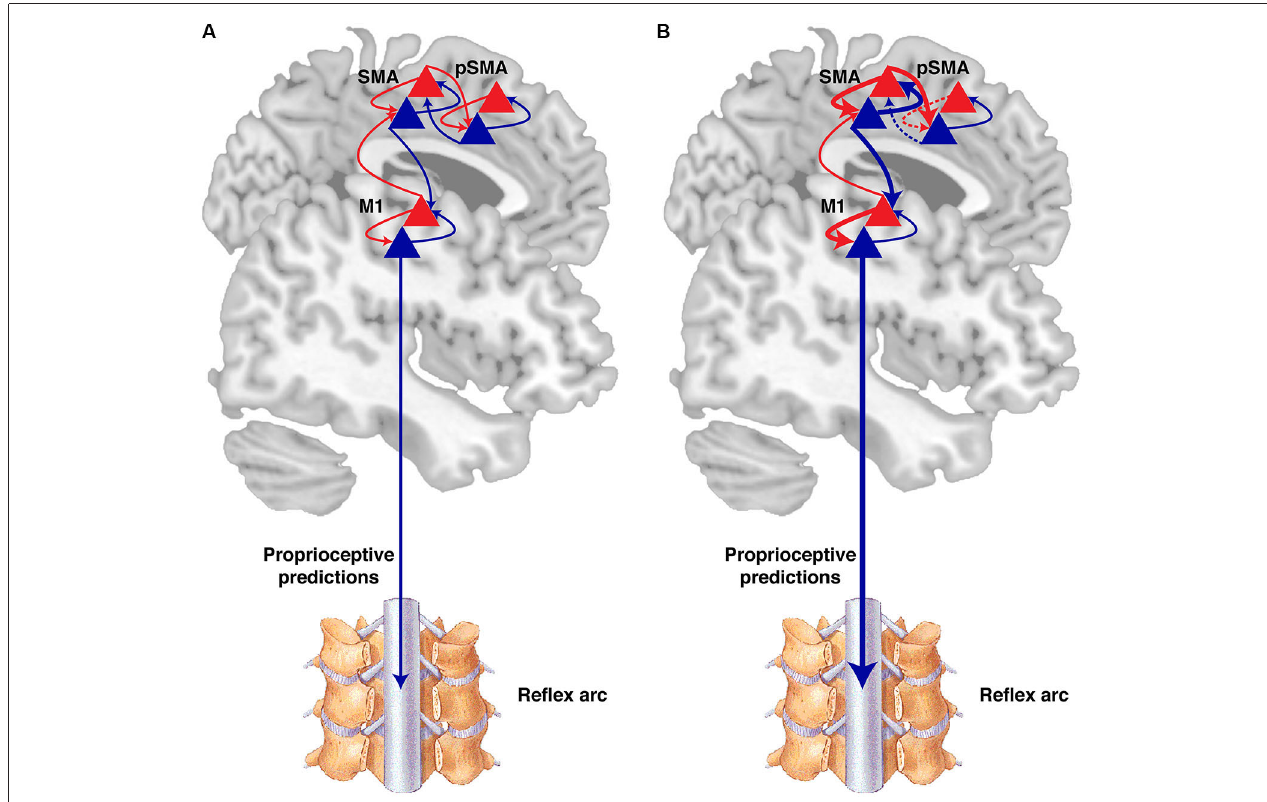
project to the primary motor cortex (M1). Even lower level predictions are sent to the spinal cord, inducing movements through reflex arcs. The sense of agency arises from the consistency between predictions in high level and lower level sensory data, balancing precision across the network. (B) In psychogenic movement disorders (PMD) for example, there is a misallocation of attention, and intermediate-level areas gain abnormally high precision (thick arrows) (Edwards et al., 2012). Consequently, prediction errors at that level induce movements through lower levels of the hierarchy, and overwhelm the higher intentional levels that initially did not predict the movement (dashed arrows). This discrepancy makes the network converge on the most likely explanation that a movement was externally caused. The figure is based on Friston et al.